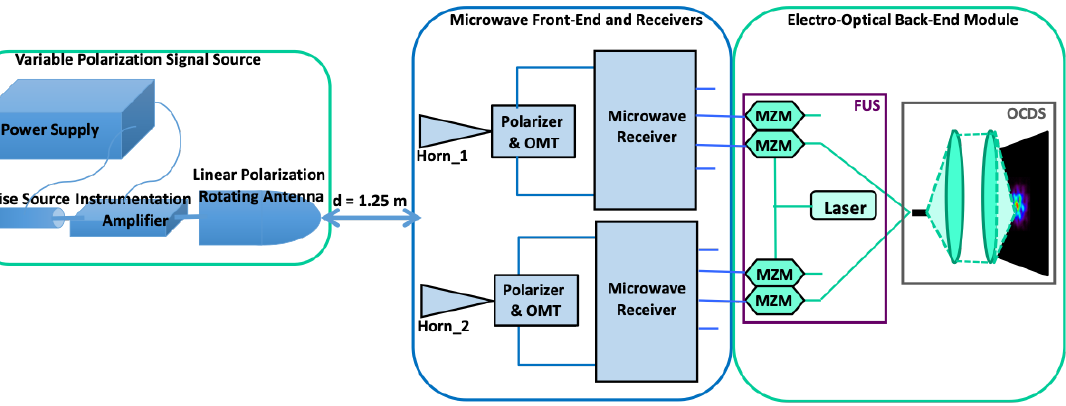
Figure 2. Sketch of the polarimeter demonstrator’s calibration test-bench. Reproduced with permis- sion from F. J. Casas, Sensors; published by MDPI, 2019 [37].